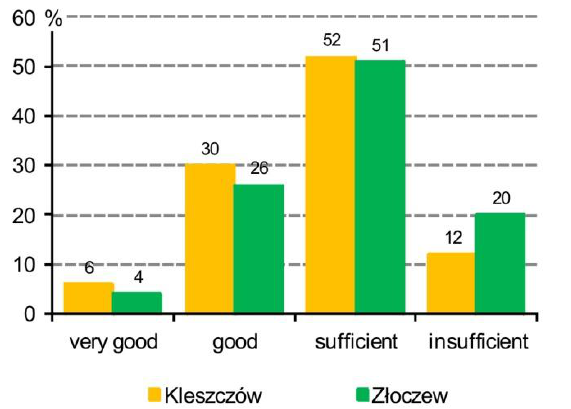
Fig. 2. How do you assess your knowledge level about brown coal mining, its economic role and its influence on the environment? The inhabitants of the Kleszczów community (n = 300) and the Złoczew community (n = 302) together (Source: Telephone interviewing (CATI), January-February